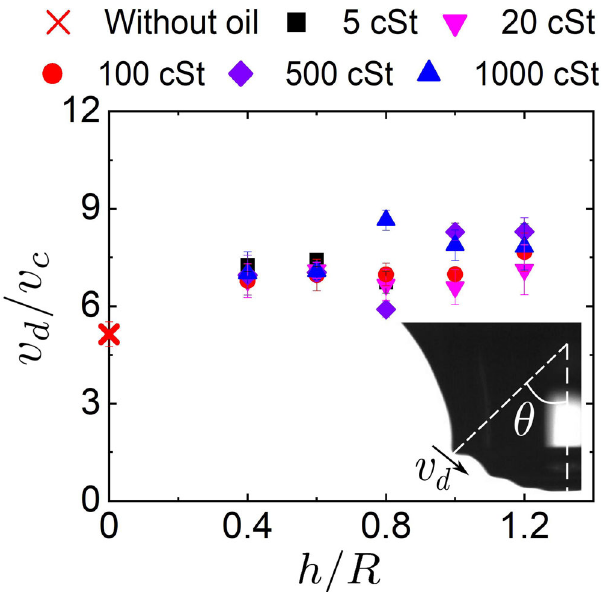
Fig. 5 Capillary wave velocity. Dependence of dimensionless velocity v d / v c of the selected dominant capillary wave on the dimensionless oil layer thickness h / R during bubble bursting at the oil-covered aqueous surface, (cid:5) (cid:6) 1 = 2 where v c ¼ γ e ρ is the inertial capillary velocity. Inset shows that v d is w R measured when the selected dominant wave goes through the position with an angle of θ = π /4 corresponding to the vertical cavity axis. Error bars are calculated as the standard deviations of data of at least 10